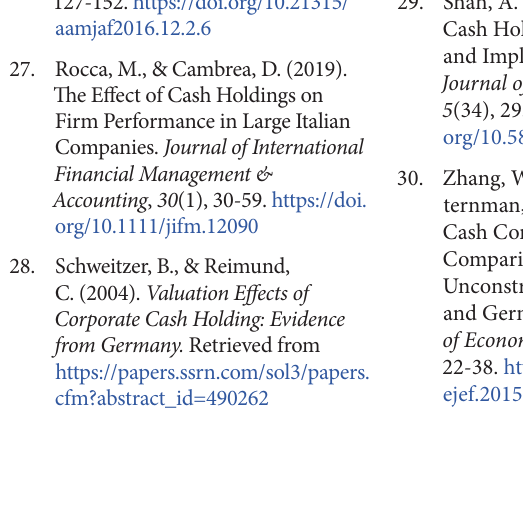
Table A1. The variables